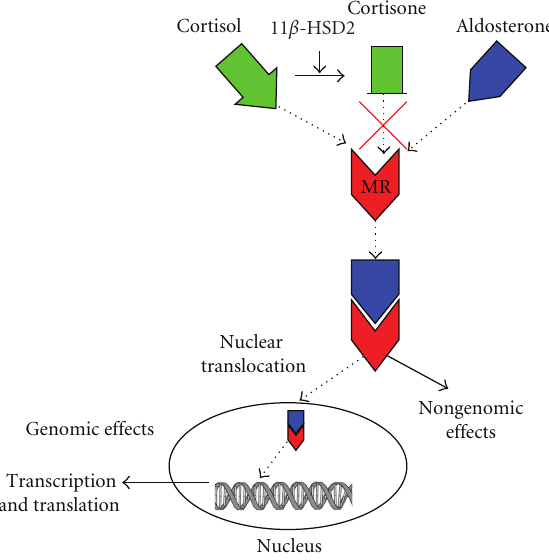
Figure 2: Cortisol and aldosterone bind the MR with equal a ffi nity, but cortisol levels are significantly higher relative to aldosterone and, thus, occupy these receptors. The enzyme 11 β -HSD2 acts to convert cortisol to cortisone, which is unable to bind the MR, thus allowing aldosterone to bind the available receptors. Once bound, the MR can translocate to the nucleus and engage DNA promoter sites to a ff ect transcription and translation (genomic e ff ects). Aldosterone can also mediate rapid nongenomic e ff ects via the MR, which does not involve gene expression and protein